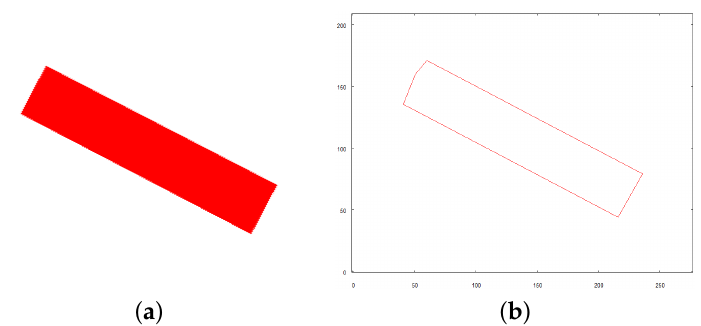
Figure 19. Object whose shape will be searched in scene to be identified and examined. ( a ) original image; ( b ) vector